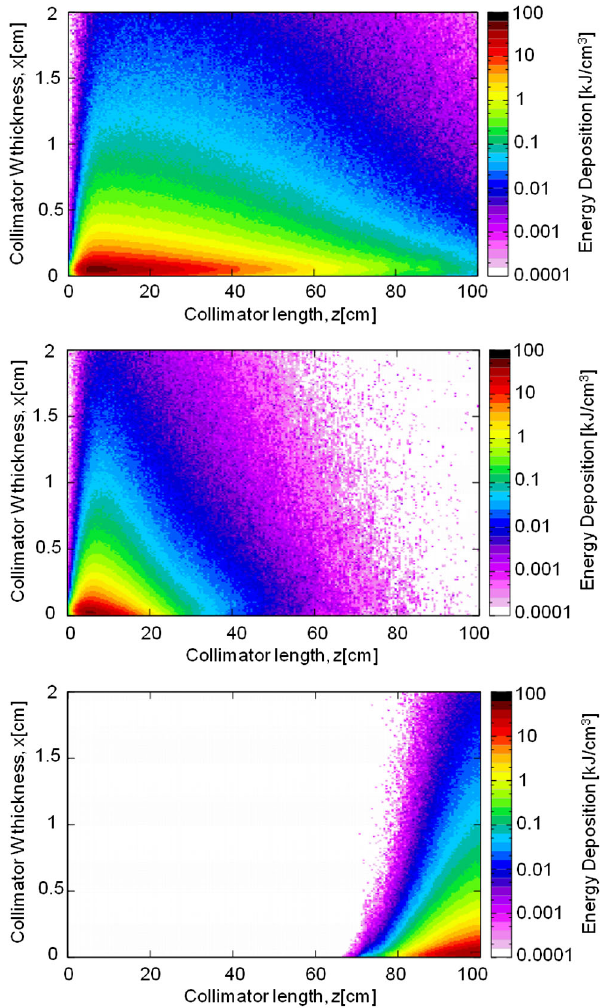
FIG. 7. Comparison of the FLUKA energy deposition maps of the W collimator jaw inserts. All cases consider 1 LHC bunch with 1 . 3 × 10 11 protons, a beam size of 0 . 3 mm × 0 . 3 mm, and an impact parameter of 0.5 mm. These maps show energy deposition x - z distributions (in kJ = cm 3 ) along the symmetry plane ( Y ¼ 0 ), for a 7 TeV particle beam impact case at θ ¼ 0 mrad (top), θ ¼ þ 5 mrad (middle) and θ ¼ − 5 mrad (bottom) angles.